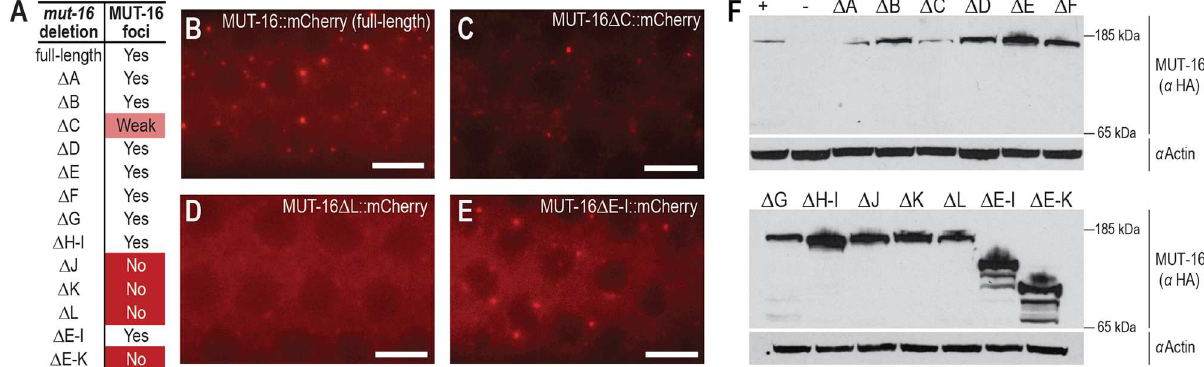
Fig 3. The C-terminal region of MUT-16 is necessary for Mutator foci formation. (A) Table indicates whether MUT-16 foci are present or absent in each mut-16 deletion strain. Yes indicates foci present in the majority of animals, No indicates foci absent or severely disrupted, and Weak (for Δ C) indicates an intermediate phenotype where the fluorescence intensity of cytoplasmic MUT-16 appeared reduced relative to the other deletion lines. (B-E) Live imaging of MUT-16::mCherry expression and localization for control strain (B) or when Δ C (C), Δ L (D), or Δ E-I (E) deletions have been introduced into the mut-16 :: mCherry strain. Scale bars, 5μm. (F) MUT-16 western blot to assess protein levels in full-length and mut-16 deletion strains. Expected sizes for MUT-16::mCherry::2xHA are 148 kD (full-length), 139 kD ( Δ A), 137 kD ( Δ B), 134 kD ( Δ C), 138 kD ( Δ D), 137 kD ( Δ E), 138 kD ( Δ F), 141 kD ( Δ G), 132 kD ( Δ H-I), 135 kD ( Δ J), 141 kD ( Δ K), 138 kD ( Δ L), 105 kD ( Δ E-I), and 85 kD ( Δ E-K).Approximately 200 synchronous adult animals were loaded per lane and actin was used as a loading